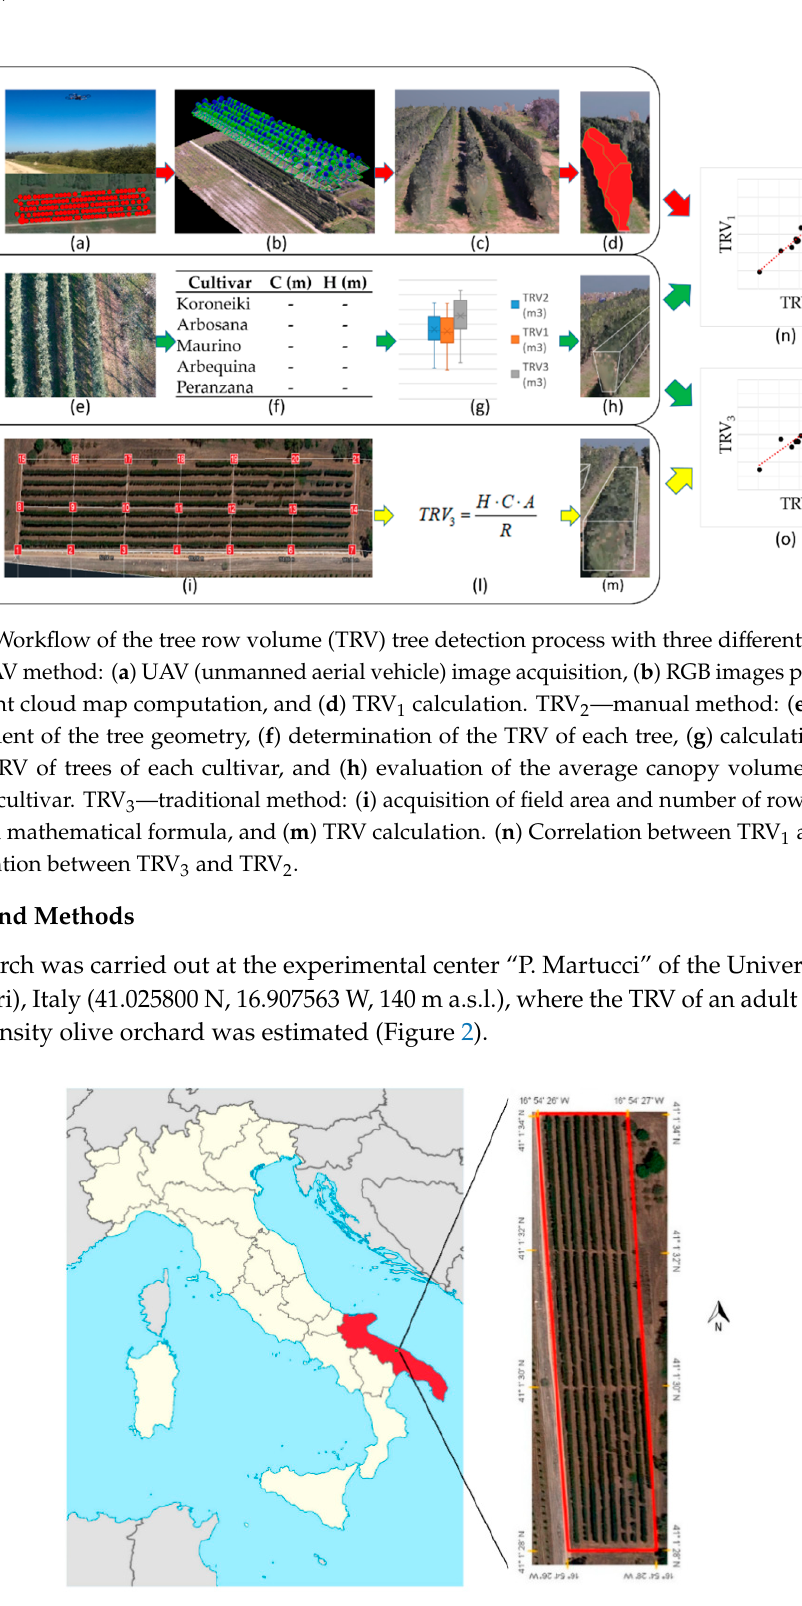
Figure 1. Workflow of the tree row volume (TRV) tree detection process with three different methods. TRV 1 —UAV method: ( a ) UAV (unmanned aerial vehicle) image acquisition, ( b ) RGB images processing, ( c ) 3D point cloud map computation, and ( d ) TRV 1 calculation. TRV 2 —manual method: